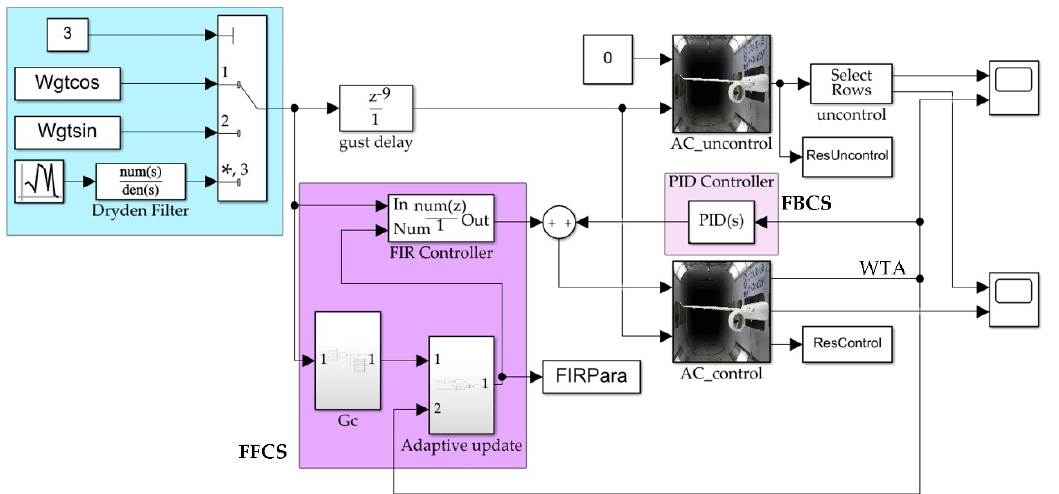
Figure 8. Simulation block diagram of combined control.